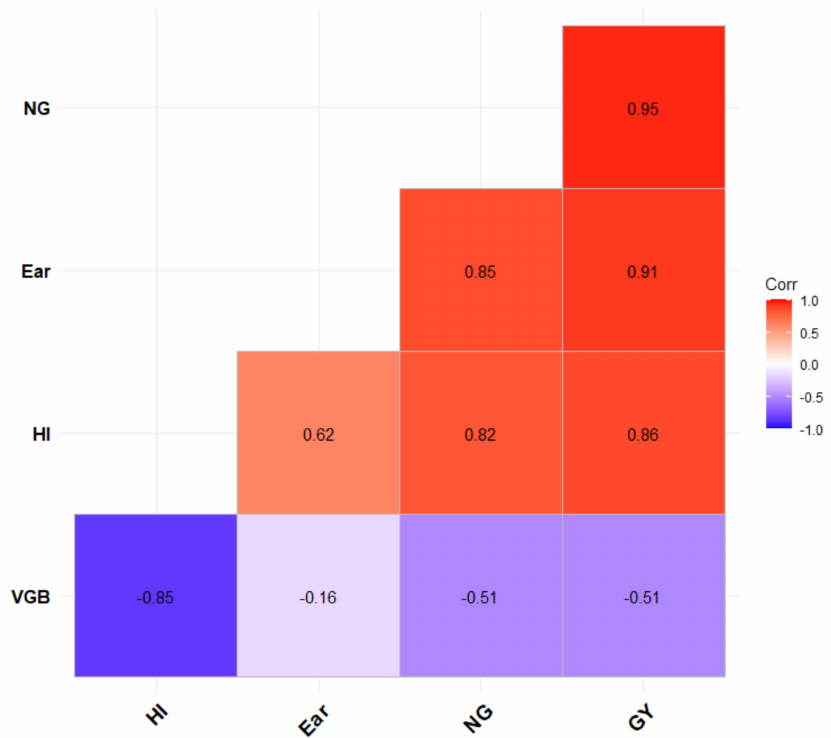
Figure 2. Correlation between grain yield, yield parameters, and water-use efficiency. VGB: vegeta- tive biomass; Ear: ear biomass; NG: number of grains; GY: grain yield; WUE_G: water-use efficiency of grains; HI: harvest index. The value shows Pearson’s correlation coefficient. The minus sign indicates a negative correlation between the variables.